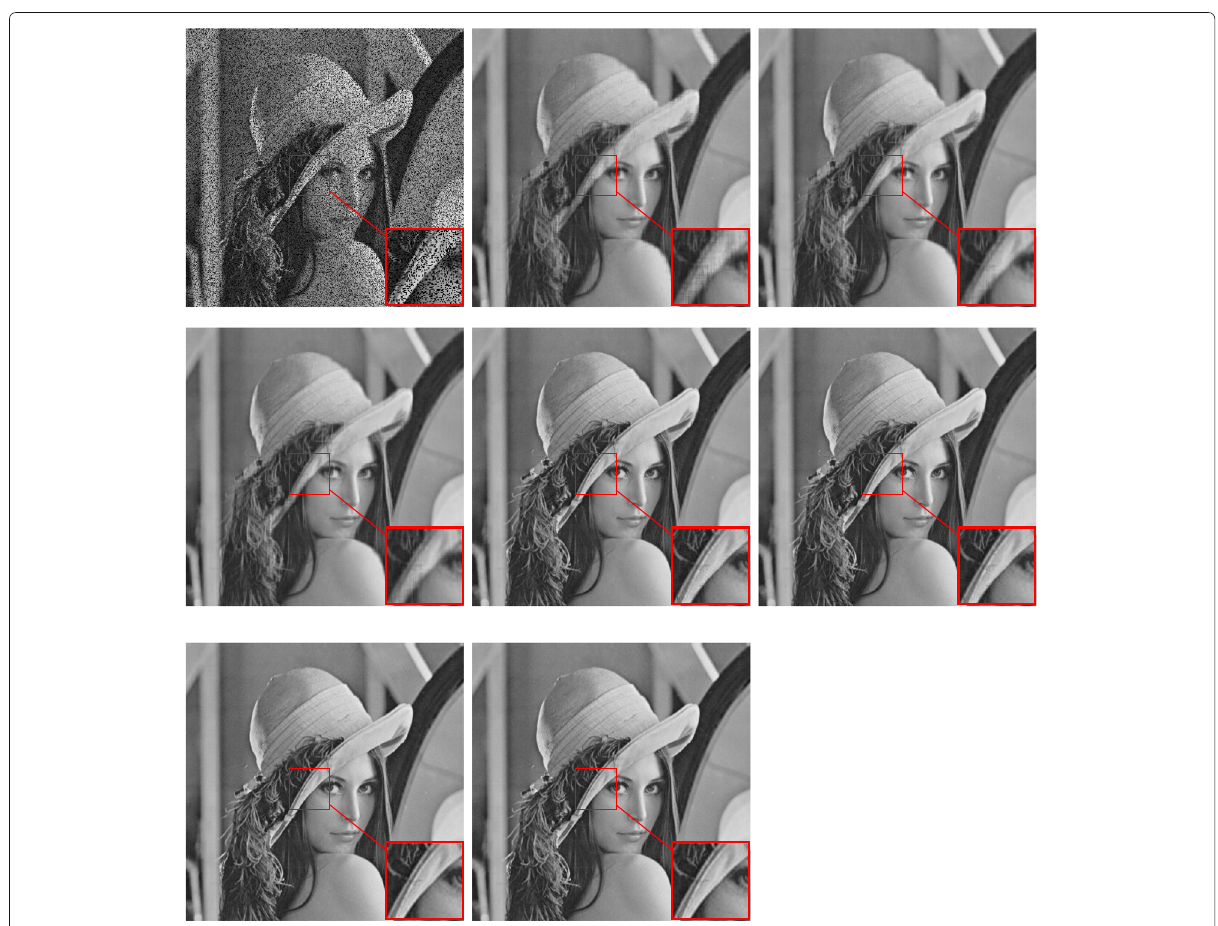
Fig. 6 Results obtained for image “Lena” using the different methods. From left to right, the order of the images is as follows: simulated image with missing data, recovered image using FPC algorithm, recovered image using ALM algorithm, recovered image using IALM algorithm, recovered image using PPG algorithm, recovered image using PG algorithm, recovered image using SVT with power method, and finally the recovered